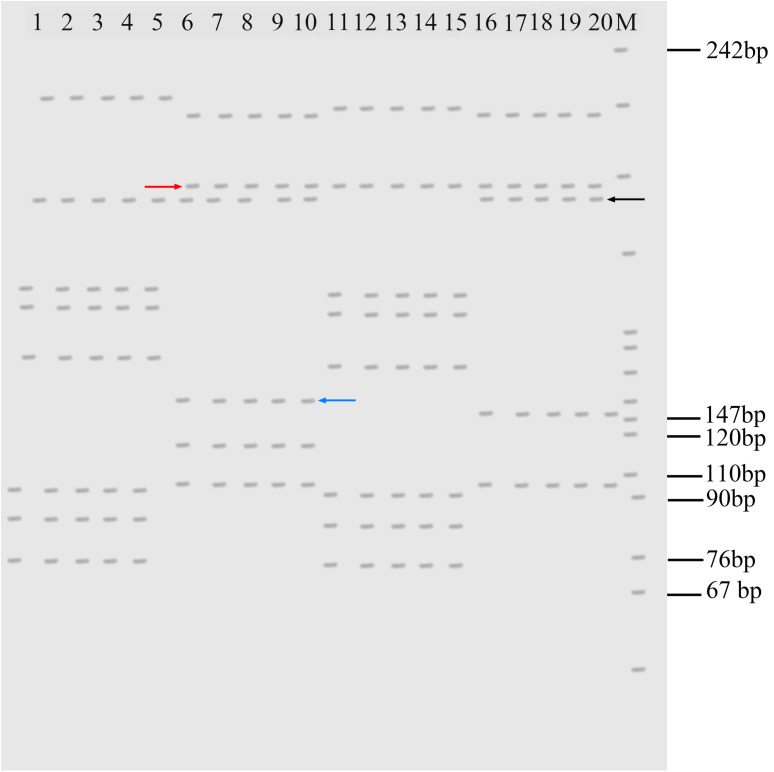
Electrophotogram of microsatellite DNA patterns produced by the primer MFW2 in KOC, RCC-L, BSB, and GF-L. Lanes 1–5 represent KOC. Lanes 6–10 represent RCC-L. Lanes 11–15 represent BSB. Lanes 16–20 represent GF-L. The black arrow indicates the DNA bands derived from KOC. RCC-L and GF-L commonly had this type of band, but BSB did not have this band. The red arrow indicates the DNA bands derived from BSB. RCC-L and GF-L commonly had this type of band, but KOC did not have this band. The blue arrow shows the band found only in RCC-L. M represents the pBR322 DNA/Mspl Marker.